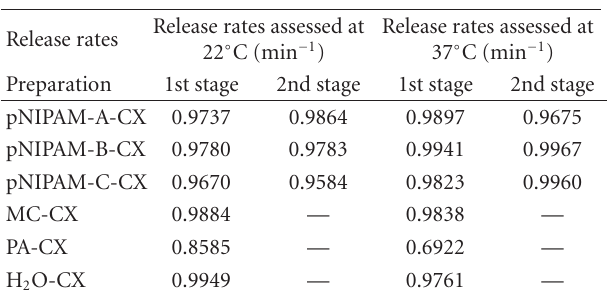
Table 2: Linear regression coe ffi cients for the assessed release of CX from the polymeric preparations, assuming first-order process.